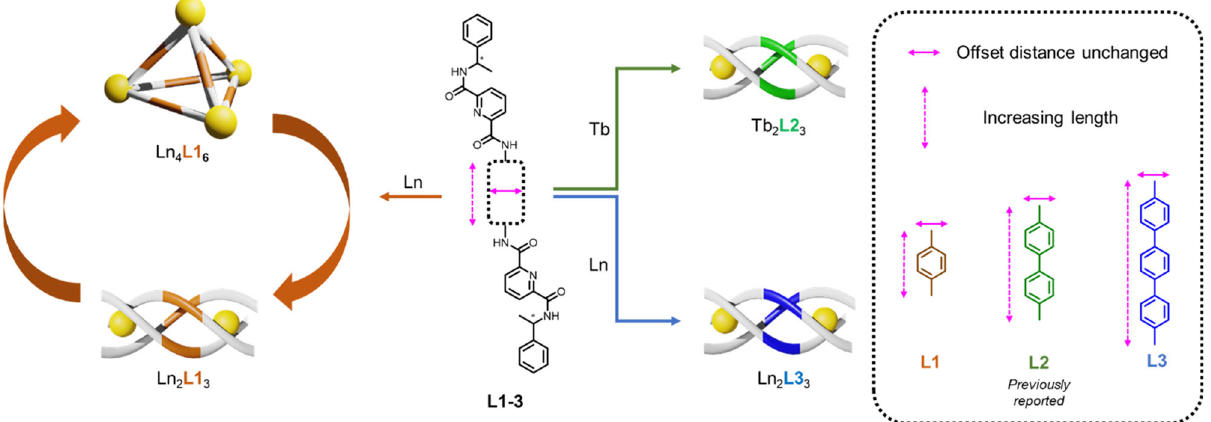
Fig. 1 Supramolecular formation of [Ln 2 L1 3 ], [Ln 4 L1 6 ]. [Tb 2 L2 3 ], and [Ln 2 L3 3 ]. The length of the spacer will greatly affect the supramolecular formation. With the use of a shorter ligand L1 , helicate-to-tetrahedron transformation was observed. For longer L2 and L3 , only stable helicates were formed and